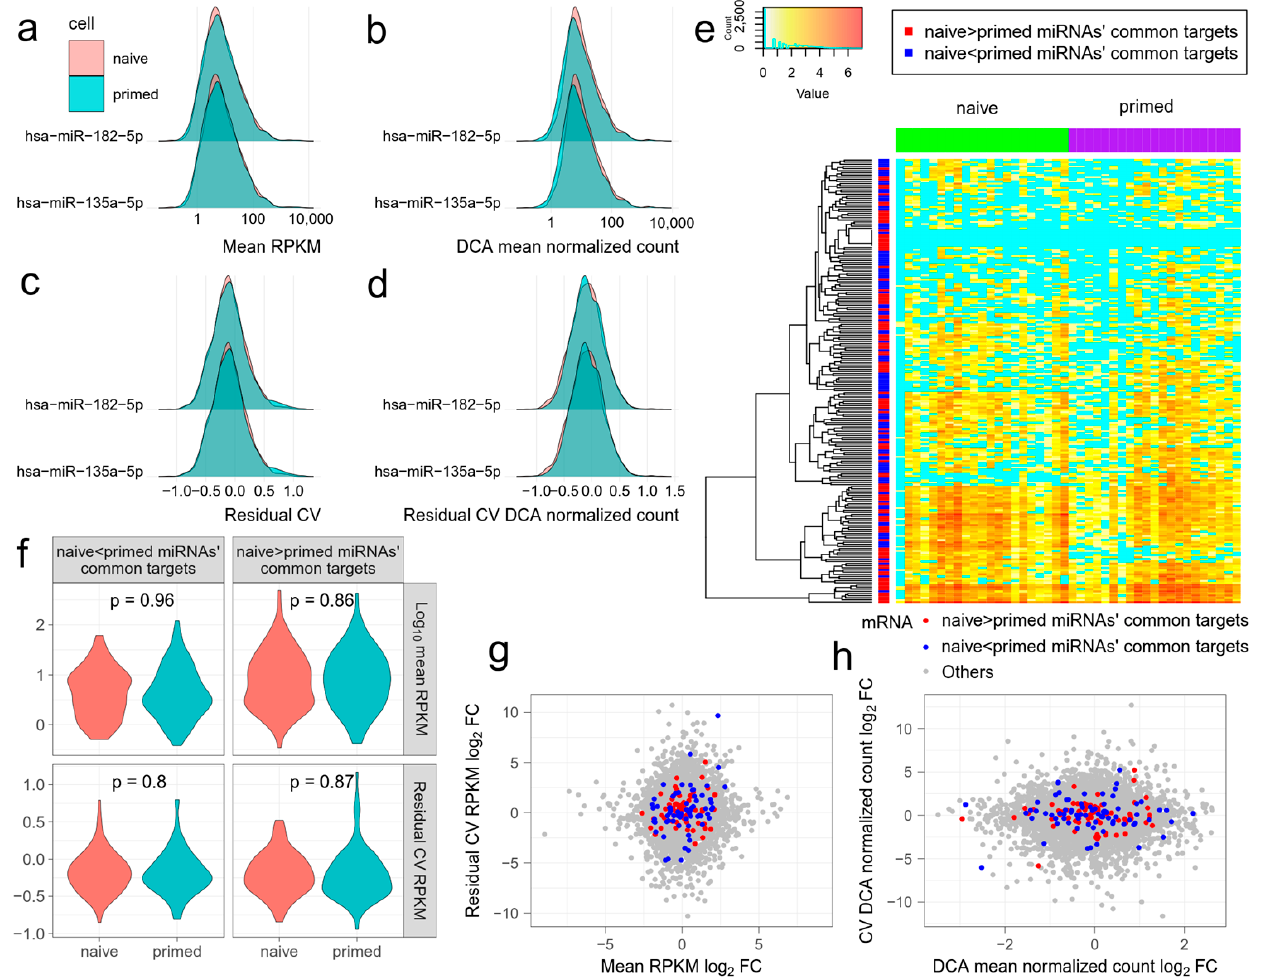
Figure 2. The effect of differentially expressed miRNAs on mean expression level and the noise of target mRNAs. miRNA and mRNA data are from GSE81287 naive and primed embryonic stem cells (ESCs). ( a–d ) Distributions of mean expression level (( a ) mean RPKM, ( b ) mean DCA normalized count) and noise of mRNAs (( c ) residual coefficient of variation (RCV) RPKM, ( d ) RCV DCA normalized count) targeted by differentially expressed miRNAs. hsa-miR-182-5p and hsa-miR-135a-5p are representative differentially expressed miRNAs, with higher expression in naive and primed ESCs, respectively. The distributions are almost identical in naive and primed ESCs. ( e ) Log(#count + 1) of the commonest mRNAs targeted by differentially expressed miRNAs in naive and primed ESCs. MRNAs targeted by miRNAs with higher expression in naive and primed ESCs have similar patterns. Zero expression is shown in cyan. ( f ) Violin plots showing the mean expression levels and noises of the commonest mRNAs targeted by differentially expressed miRNAs in naive and primed ESCs. ( g , h ) The log fold change of the mean expression level and noise of all the mRNAs in naive and primed ESCs. The commonest mRNAs targeted by differentially expressed miRNAs do not generally deviate from the origin. ( g ) Mean RPKM and RCV RPKM. ( h ) Mean DCA normalized count and RCV DCA normalized count.